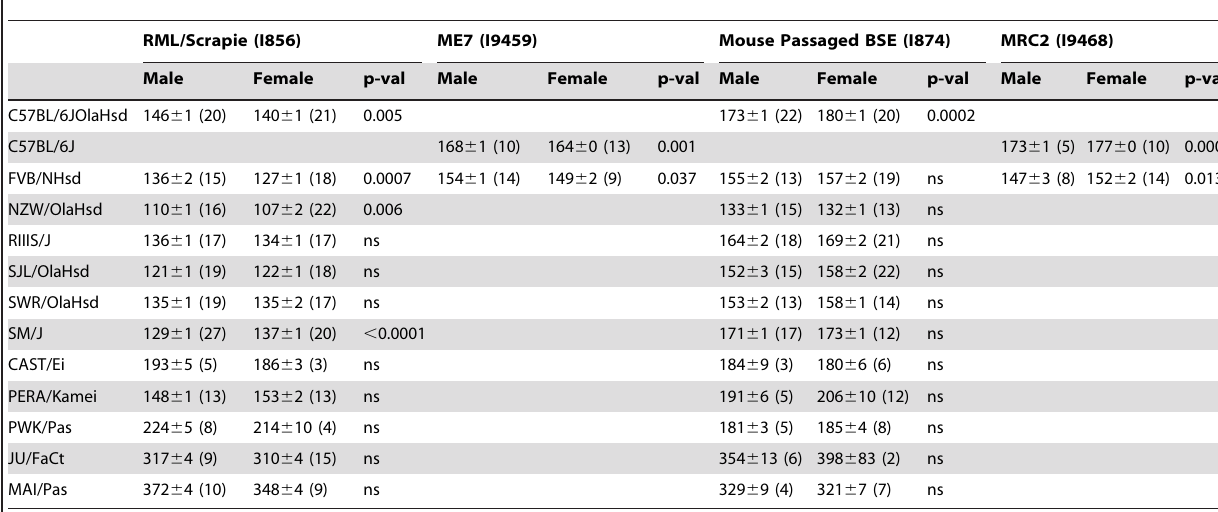
Table 1. Prion incubation